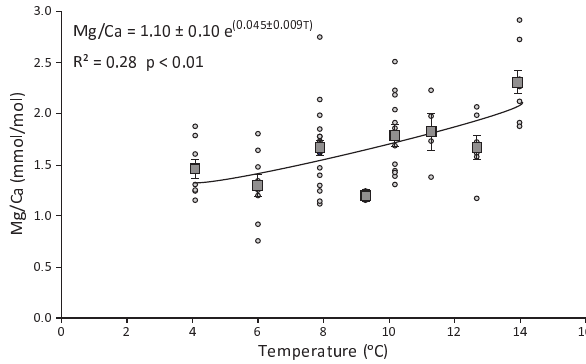
Fig. 2. Mg/Ca versus temperatures for all experiments with B. marginata . The error bars are based on the standard error of the √ n ). mean ( σ /